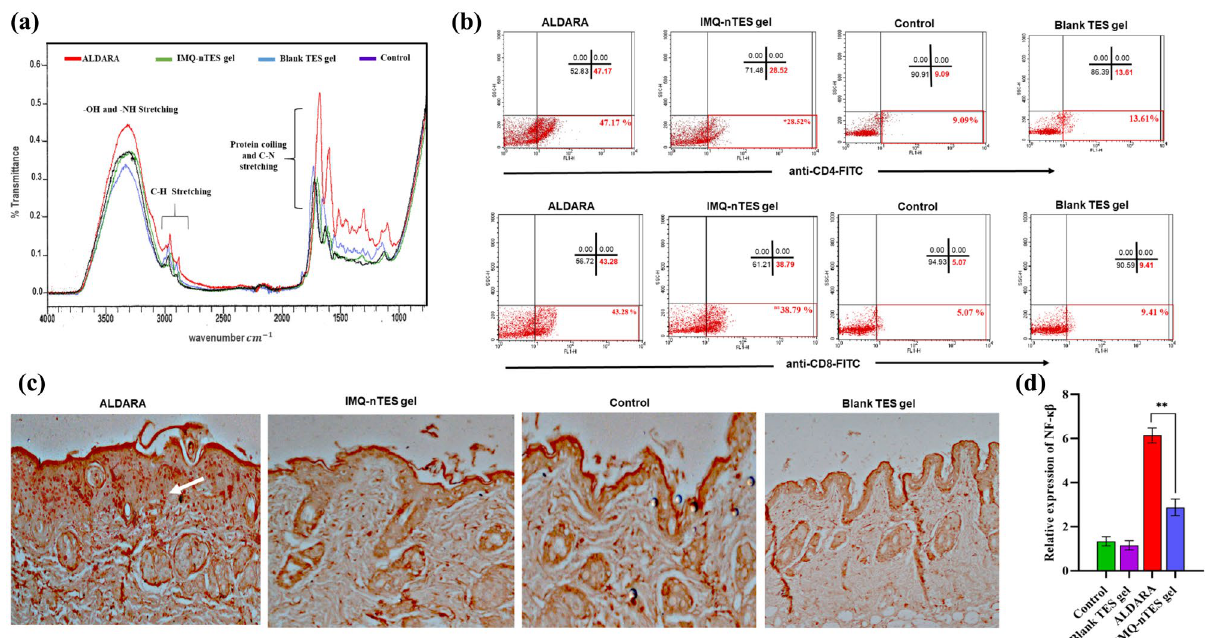
Figure 8. ( a ) FTIR curve of control group, Blank TES gel, IMQ-nTES gel and ALDARA treated skin (at day-7). ( b ) Flowcytometry for quantification of CD4 + T-cells and CD8 + T-cells population in skin of day-7 dissected mice of all groups. ( c ) IHC for NF-κβ expression in day-7 excised cutaneous tissue, with constitutive NF-κβ expression (round orange dots indicated by white arrow) in ALDARA treated skin. ( d ) Relative expression of NF-κβ in all experimental group. The data is presented as mean ± S.D. *p < 0.05, **p < 0.01, ***p < 0.001, ns p > 0.05.